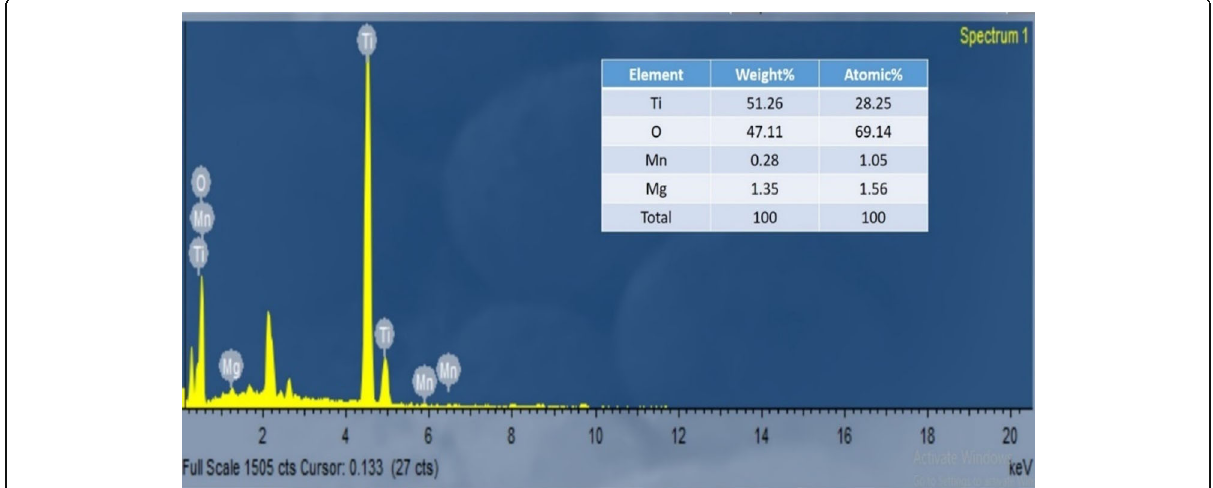
Fig. 5 EDX spectrum of 0.25wt% Mn 2+ and 1.00wt% Mg 2+ bimetal doped TiO 2 in the presence of 10wt% of surfactant (MMT5-GS2) after